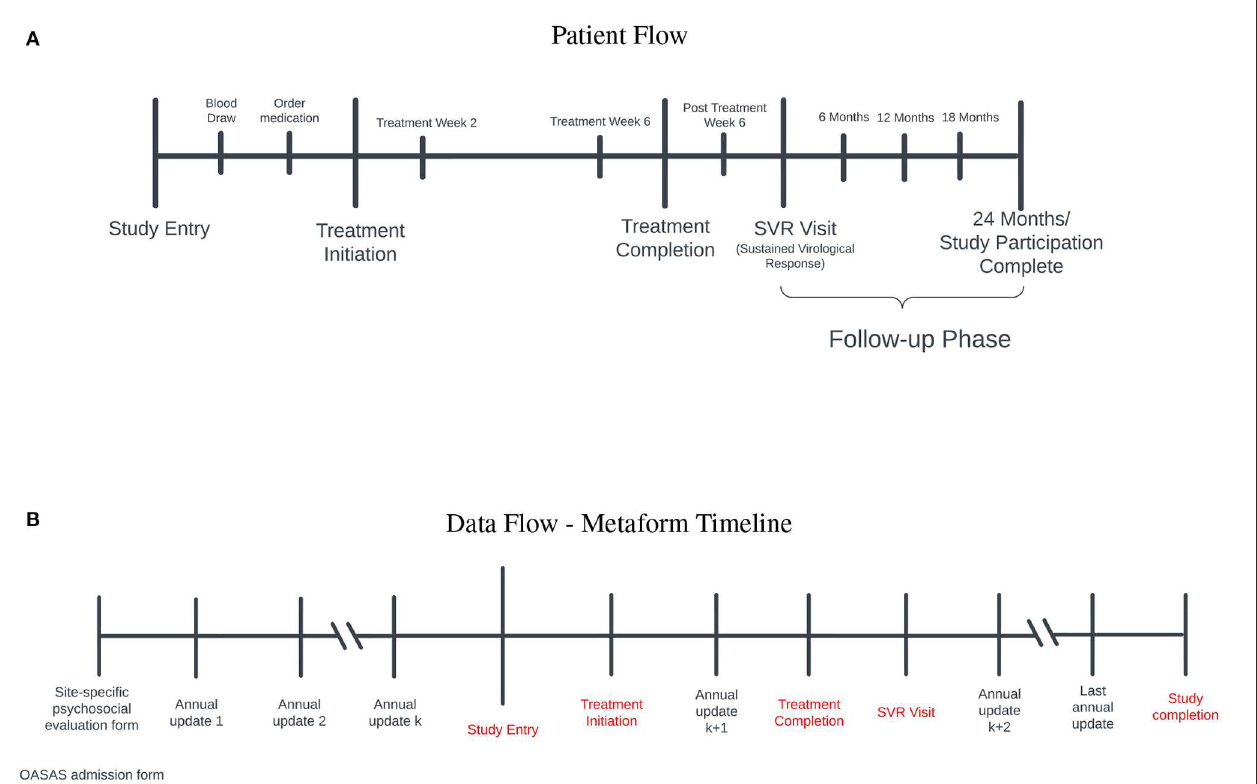
FIGURE1 (A) Patient flow: Study entry occurred between 2017 and 2020. Prior to initiation of treatment for hepatitis C virus (HCV) infection, blood was obtained to ensure active infection and medications were ordered. After treatment initiation, participants were evaluated at treatment weeks 2 and 6 to ensure that the level of the virus was below detection. Once treatment was completed, participants were followed for 3 months to ensure a sustained virological response occured (SVR) (i.e., cure). Those who achieved a cure entered the follow-up phase for 2 years to ensure persistence of the cure. (B) Data flow-metaform timeline: Illustrated is the data flow (black) and significant study timepoints (red). Site-specific psychosocial evalaution and OASAS admission forms are collected on admission to the opioid treatment program. OASAS annual updates are completed anually. We were able